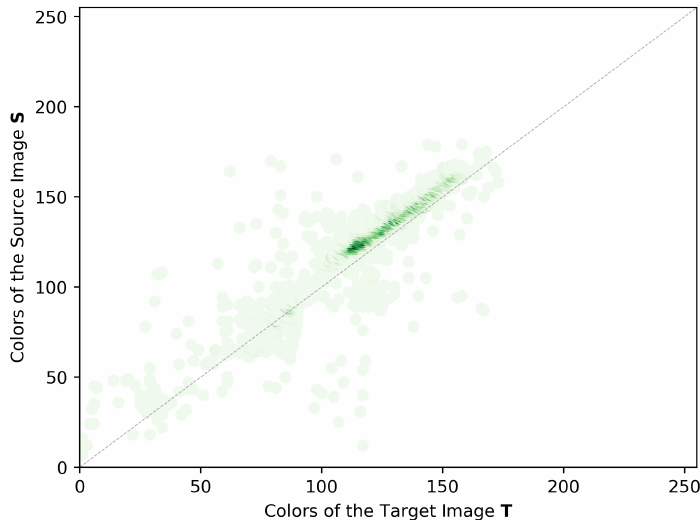
Figure 5. Example of the green channel of a JIH using the filtered pairwise